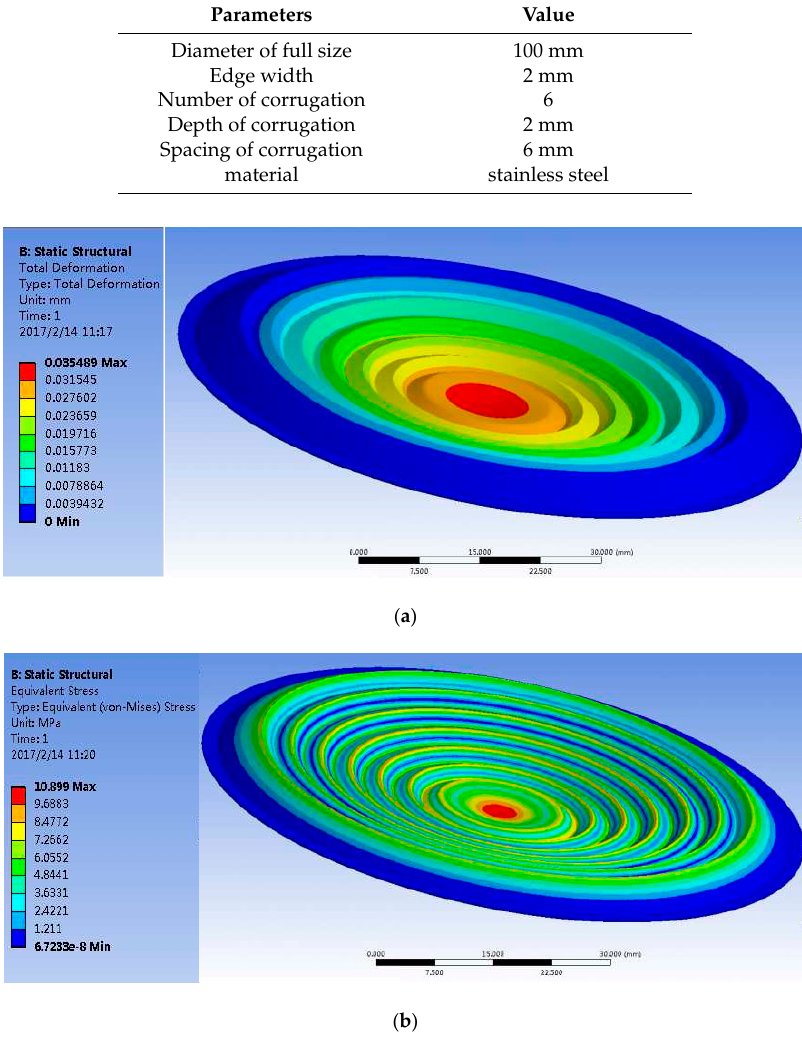
Figure 7. ( a ) Deformation of diaphragm; ( b ) Force distribution of diaphragm.